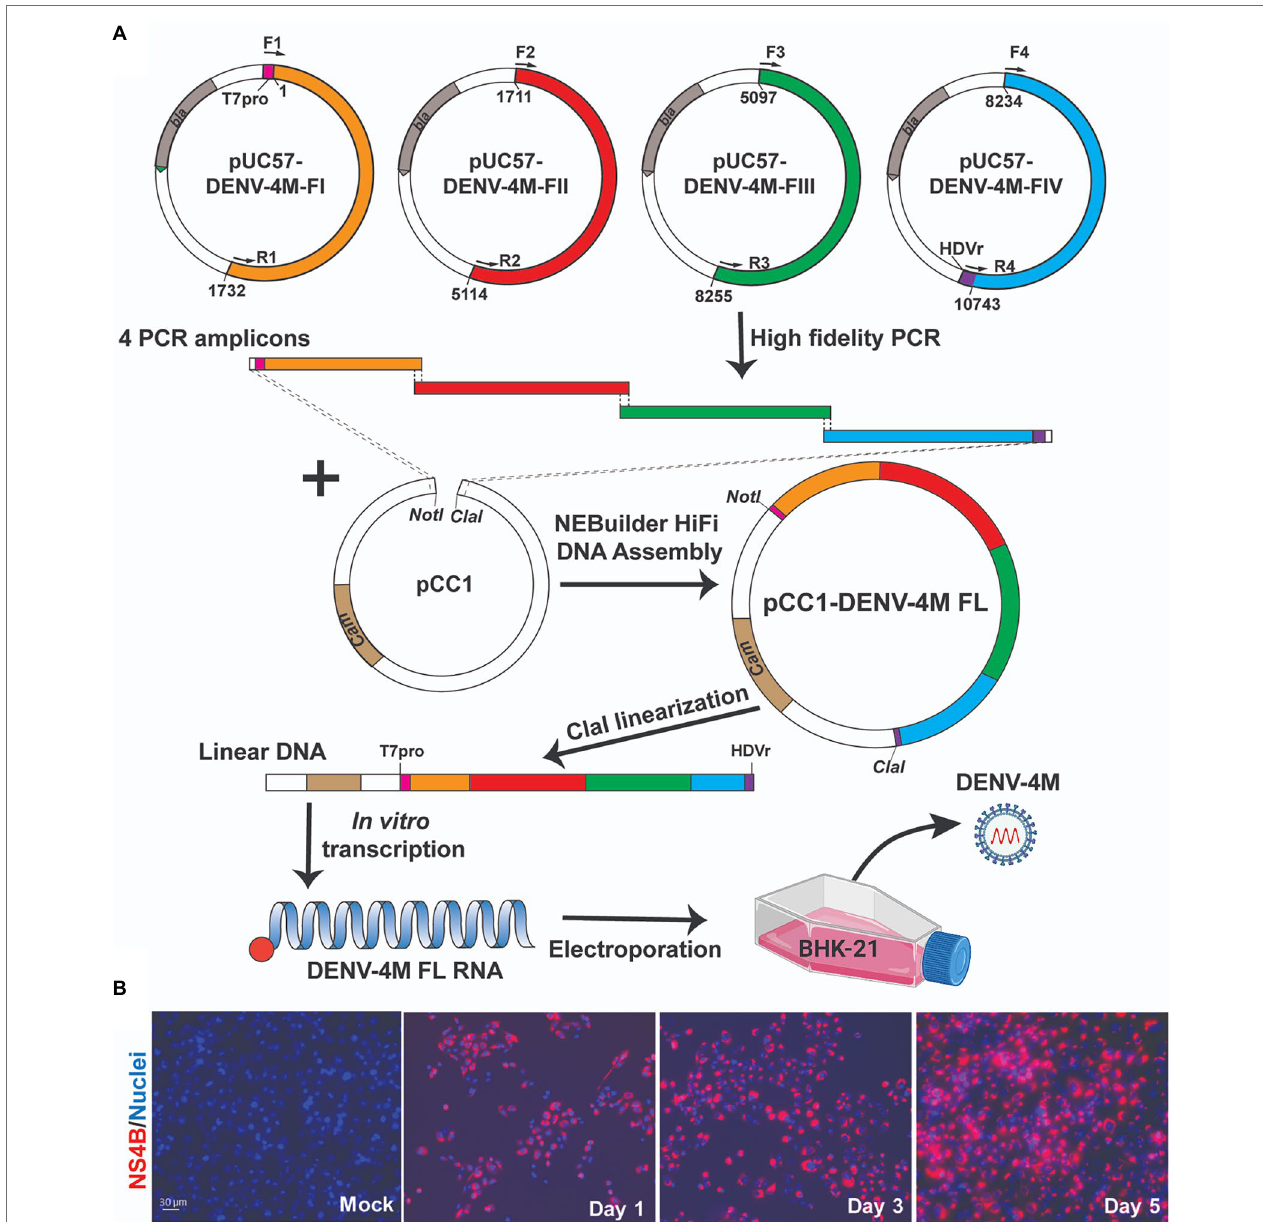
FIGURE 1 | Manatee County DENV-4 (DENV-4M) parental infection data show active replication in mammalian cell culture. (A) Diagram of construction of DENV- 4M infectious clone and generation of recombinant viruses. (B) Immunofluorescence assay (IFA) analysis of baby hamster kidney fibroblast (BHK-21) cells transfected with in vitro transcribed viral RNA. On days 1, 3, and 5 after transfection, cells were assayed by immunofluorescence for DENV nonstructural protein 4B (NS4B; red). Nuclei are stained with DAPI